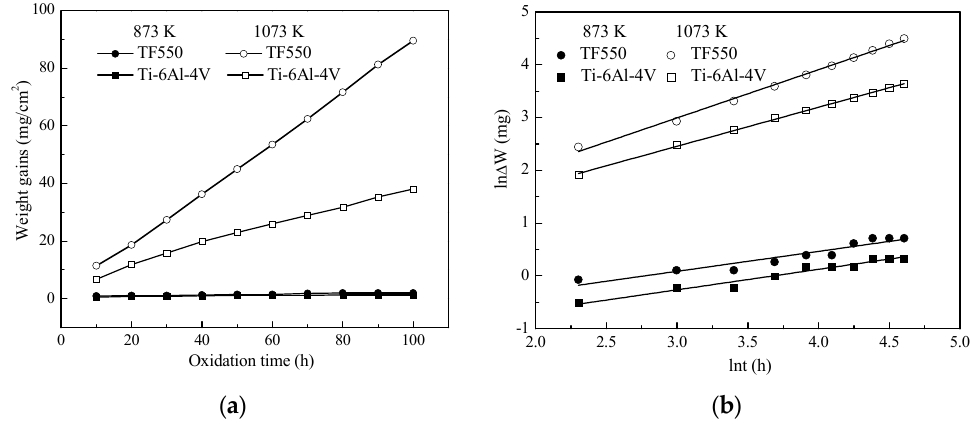
Figure 1. Oxidation kinetics curves of TF550 alloy along with Ti–6Al–4V alloy at temperatures of 873 and 1073 K. ( a ) Oxidation weight gain curves and ( b ) double logarithmic curves.